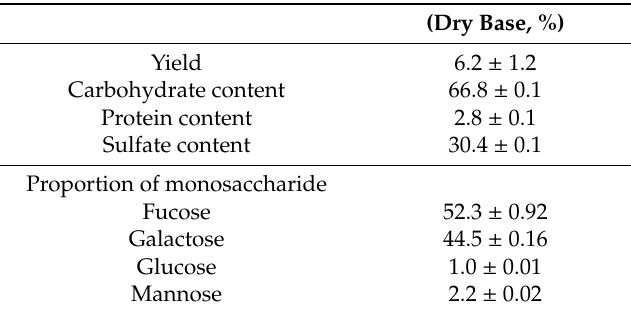
Table 1. Yield, proximate chemical composition, and monosaccharide compositions of the celluclast enzyme extract of U. pinnatifida sporophylls